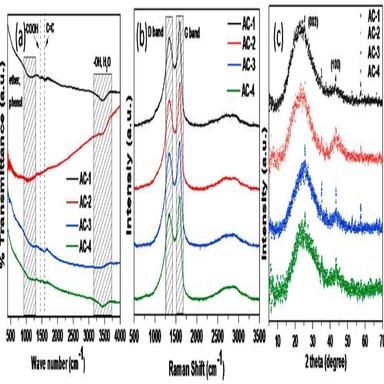
(a) Transmission-mode FTIR spectra of ACs,(b) Raman spectra, using 532 nm excitation laser, featuring graphitic D and G bandsand(c) XRD profiles, showing diffraction corresponding to graphitic (0 0 2) and (1 0 0) Bragg's planes.